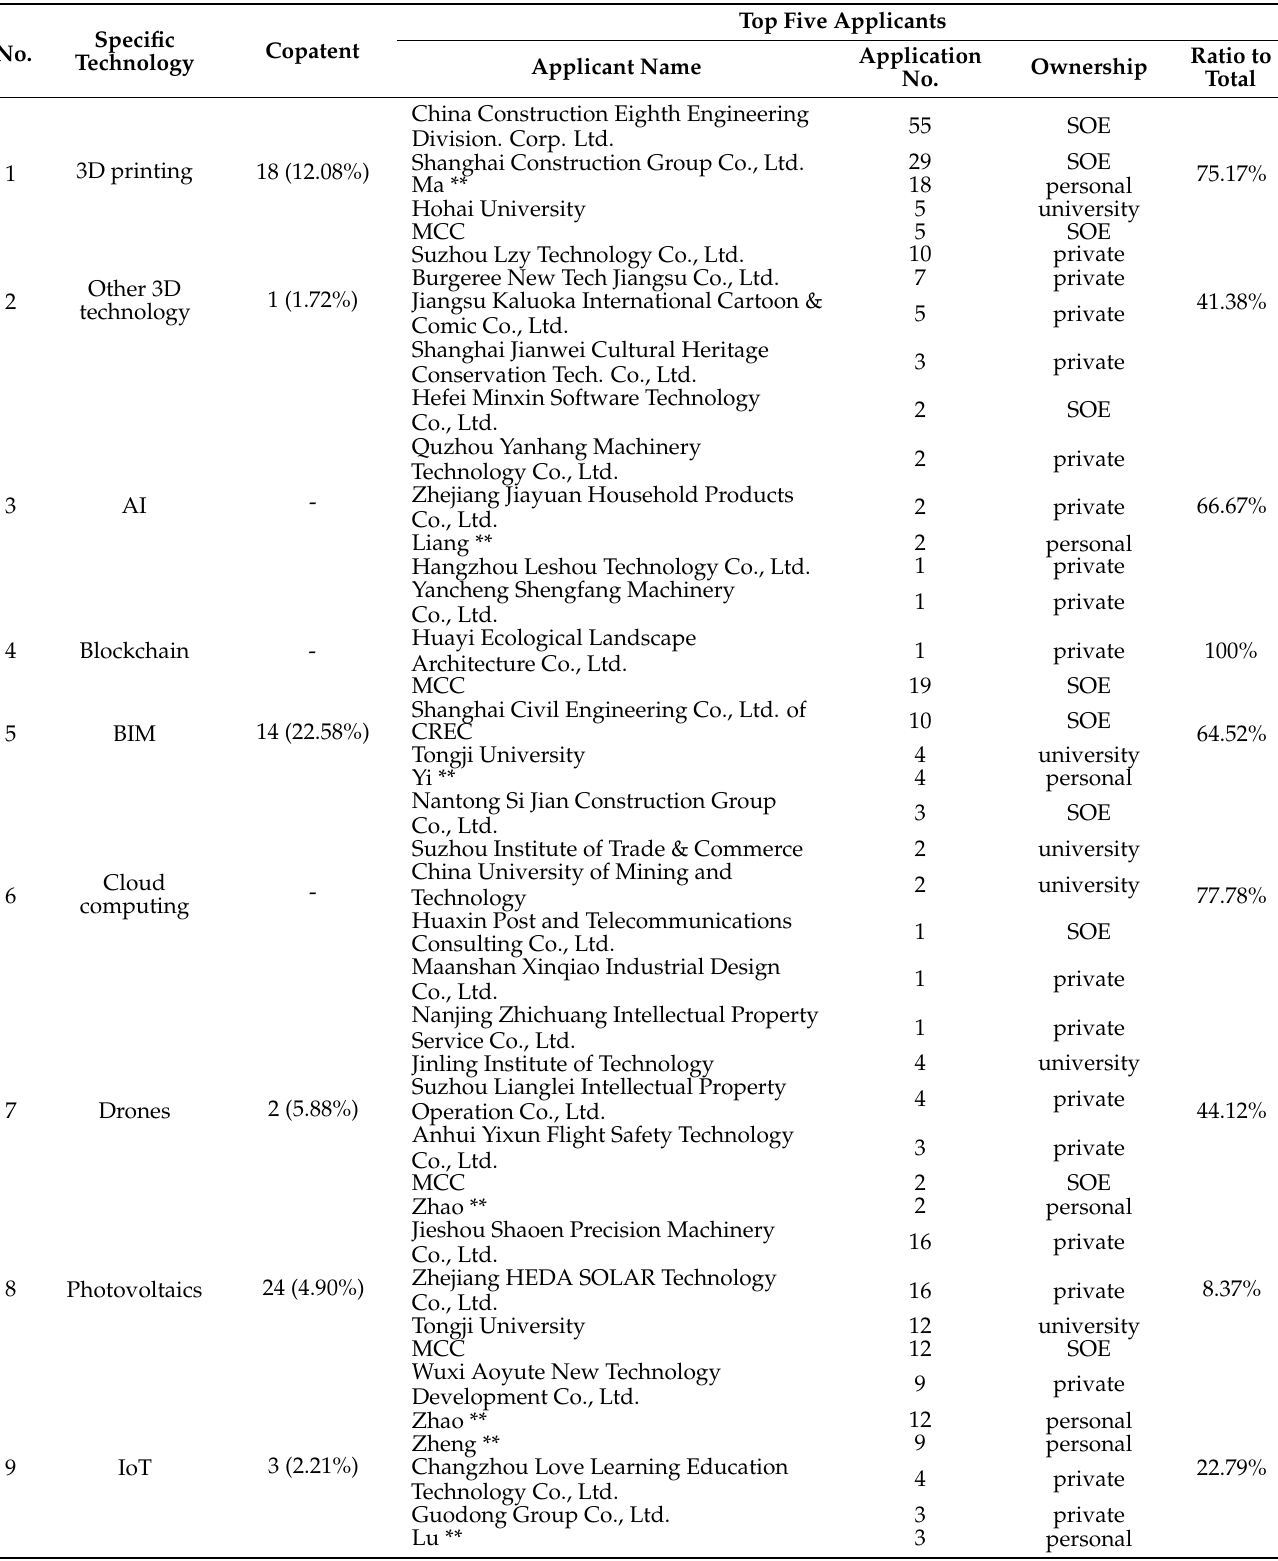
Table 2. Copatents and the top five applicants in each